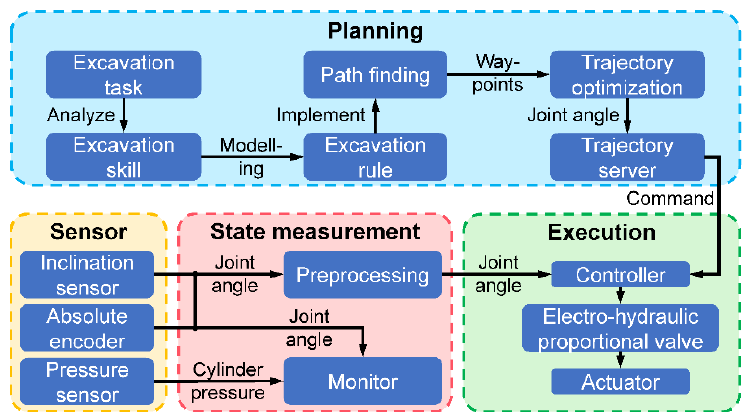
Figure 2. The architecture of the software